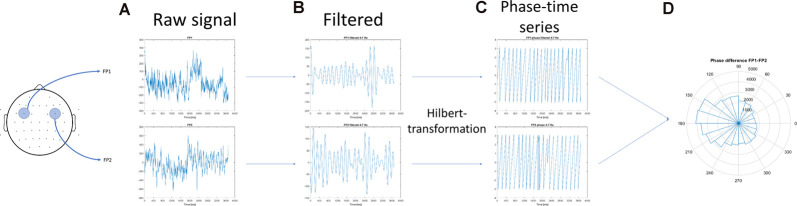
Schematics of the calculation of the inter-site phase coherence. (A) The artifact-free electroencephalography (EEG) segments in two (non-neighbor) channels were obtained. (B) The concatenated time series were filtered to 5–10 Hz, and (C) the Hilbert transformation was performed on the filtered data. (D) The mean resultant vector of the phase difference between the two channels was calculated.